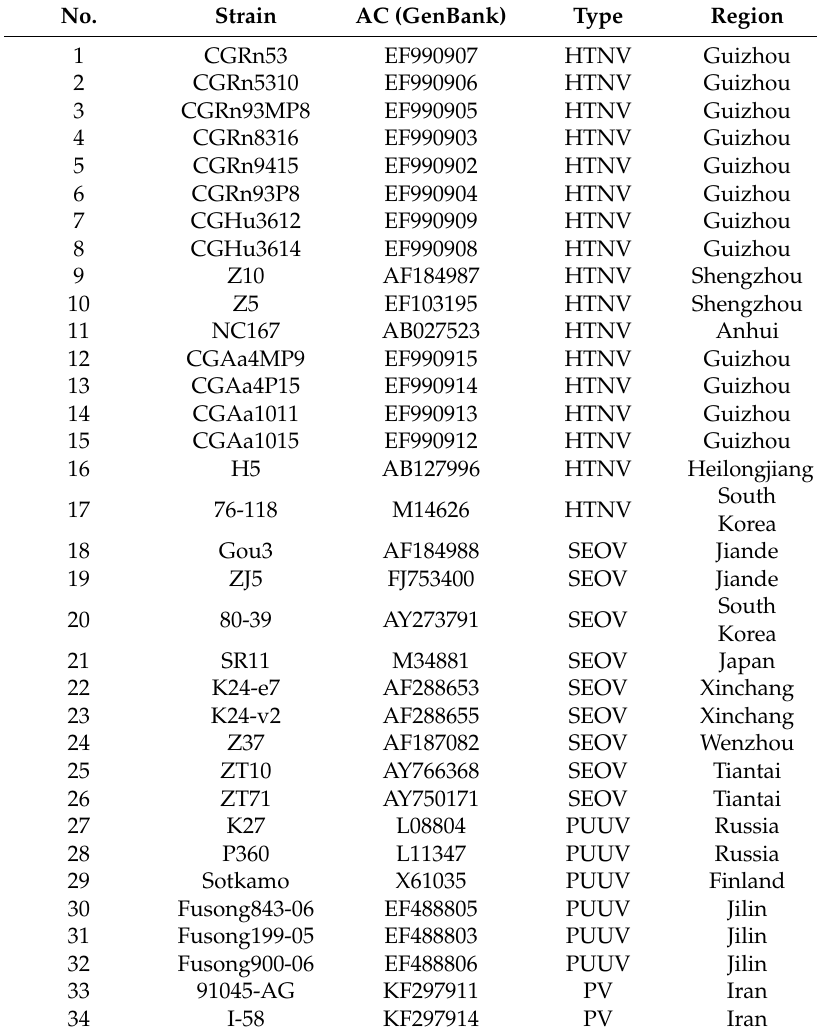
Table 5. Sequence information of S segment of